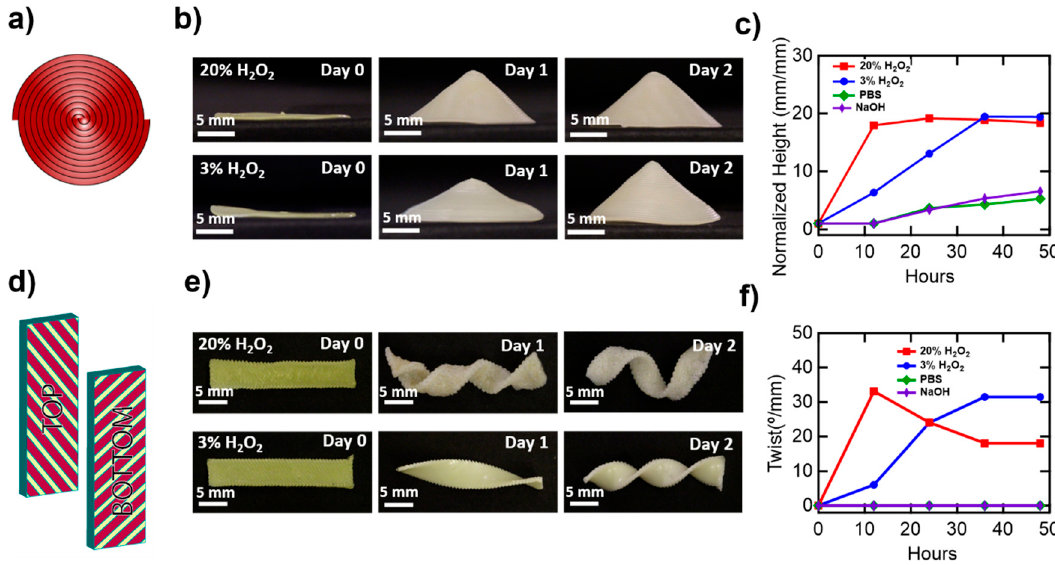
Figure 5. Shape change of 3D printed nonuniaxial structures. ( a ) Print path schematic of a disc with an azimuthal alignment pattern. ( b ) Side view images of 3D printed discs before and after oxidation in 20% H 2 O 2 and 3% H 2 O 2 . LCEs swell anisotropically and morph from a flat to conical shape. ( c ) Normalized cone height as a function of time after exposure to all media. ( d ) Print path schematic of bilayer LCE strips with the print path of opposing layers directed to be ±45° to the long axis of the film. ( e ) Flat rectangular bilayers morph into spiral ribbons or helicoids after oxidation. ( f ) Number of twists as a function of time demonstrating effect of media on bilayer.